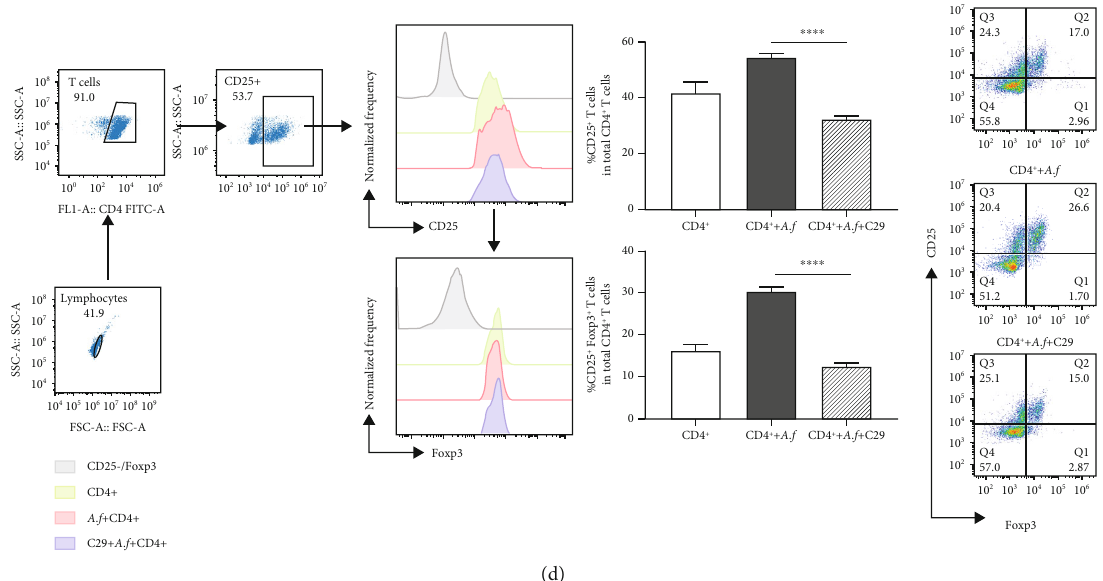
Figure 4: TLR2 a ff ects the proliferation of CD4 + CD25 + Foxp3 + Treg in lung injury caused by Aspergillus fumigatus . (a) CD4 + CD25 + T cells and CD4 + CD25 + Foxp3 + Tregs in the spleen were detected by fl owcytometry, and the proportions were analyzed by FlowJo10 as prior described in Section 2. Reduced CD4 + CD25 + T cell and CD4 + CD25 + Foxp3 + Treg proportion signi fi cantly in the spleen of A. fumigatus infection TLR2 − / − mice ( n = 5 /group). (b) Foxp3 mRNA levels in the lungs were measured with qRT-PCR ( n = 3 /group). (c) The expression of Foxp3 protein in lungs of C57BL/6 mice and TLR2 − / − mice was infected with A. fumigatus for 3 days which was detected by Western blot and analyzed by imager systems described in Section 2 ( n = 3 /group). CD4 + T cells were sorted from the spleens of wild-type C57BL/6 mice and cultured. Tregs were detected by fl ow cytometry on day 3 and analyzed by FlowJo10. (d) CD4 + T lymphocytes di ff erentiated fewer CD4 + CD25 + T cells and CD4 + CD25 + Foxp3 + Tregs after treatment with C29. In each group, n = 5 ; three replicate experiments were performed three times. ns: not signi fi cant; ∗ p < 0 : 05 , ∗∗ p < 0 : 01 , ∗∗∗ p < 0 : 001 , and ∗∗∗∗ p < 0 : 0001 by the one-way ANOVA and the two-way ANOVA followed by the Tukey post hoc test. Error bars represent